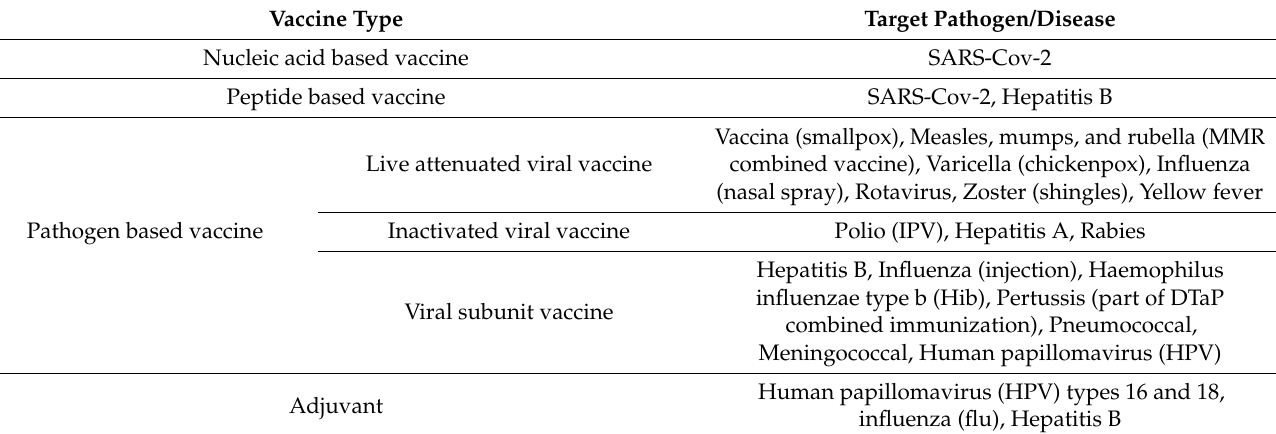
Table 1. Different types of currently available protocols employed in vaccine